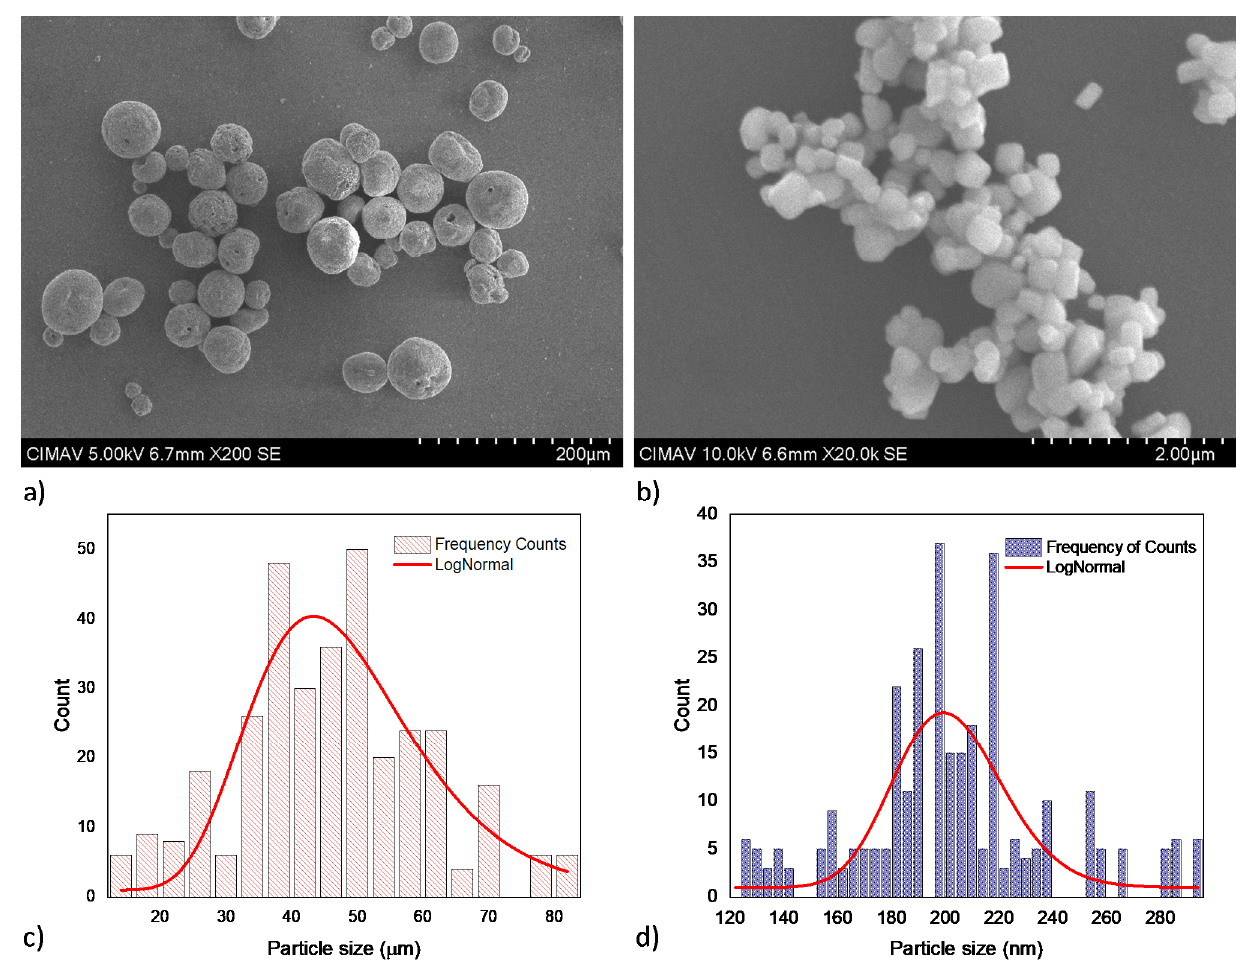
Figure 1. Primary powders SEM micrographs and the respective particle size histograms for: ( a ) and ( c ) HA, ( b ) and ( d ) BT.